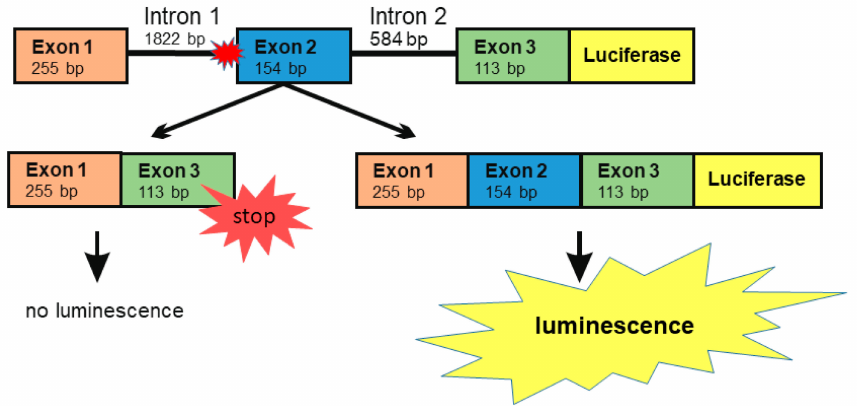
Figure 4. The AGA minigene constructs with firefly luciferase. Genomic DNA was isolated from the patient fibroblasts. The region comprising exons 1–3 was amplified by standard PCR and cloned into the pcDNA3 vector. Firefly luciferase (without the ATG start codon) was cloned in-frame downstream of the AGA minigene. Skipping of exon 2 will lead to a frame shift and early termination of translation, resulting in lack of luciferase signal. The correct splicing with inclusion of all three exons produces a fusion protein containing a C-terminal luciferase protein whose activity can be measured by